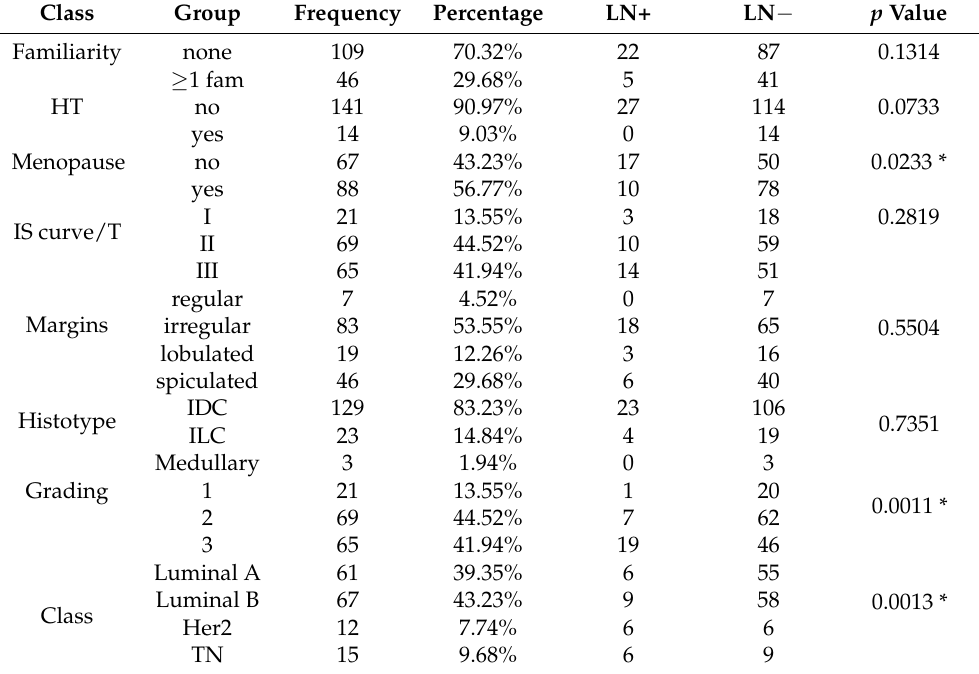
Table 4. Patient and tumor feature frequencies and relative percentages are reported in relation to the final label (lymph node LN − involvement). The difference between the two groups (LN+ vs. LN − ) was reported, and the statistical significance was set at 0.05 (*). HT (hormonotherapy), IS curve/T (intensity signal curve/time), IDC (invasive ductal carcinoma), ILC (invasive lobular carcinoma), TN (triple